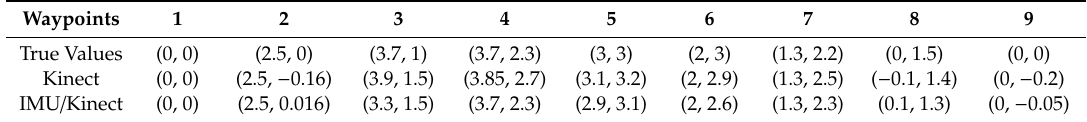
Figure 12. Polygon track. Table 9. Control points’ coordinates of the Polygon test (in meters).